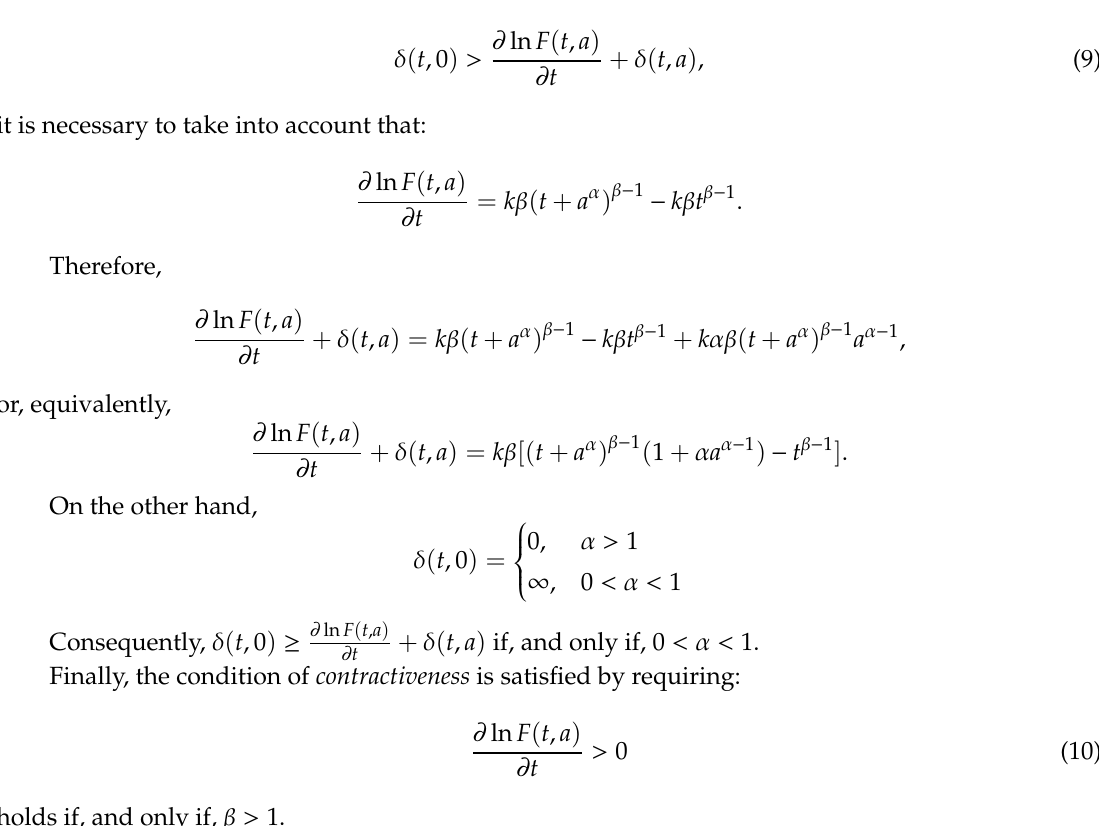
Table 1. Delay e ff ect according to the values of α and β . Source: Own elaboration.” Values of β 0 < β < 1 β = 1 β > 1 0 < α < 1 SUB2 Generalized exponential discounting ? α = 1 SUB2 Exponential discounting RSUB2 Values of α α > 1 ? Generalized exponential discounting